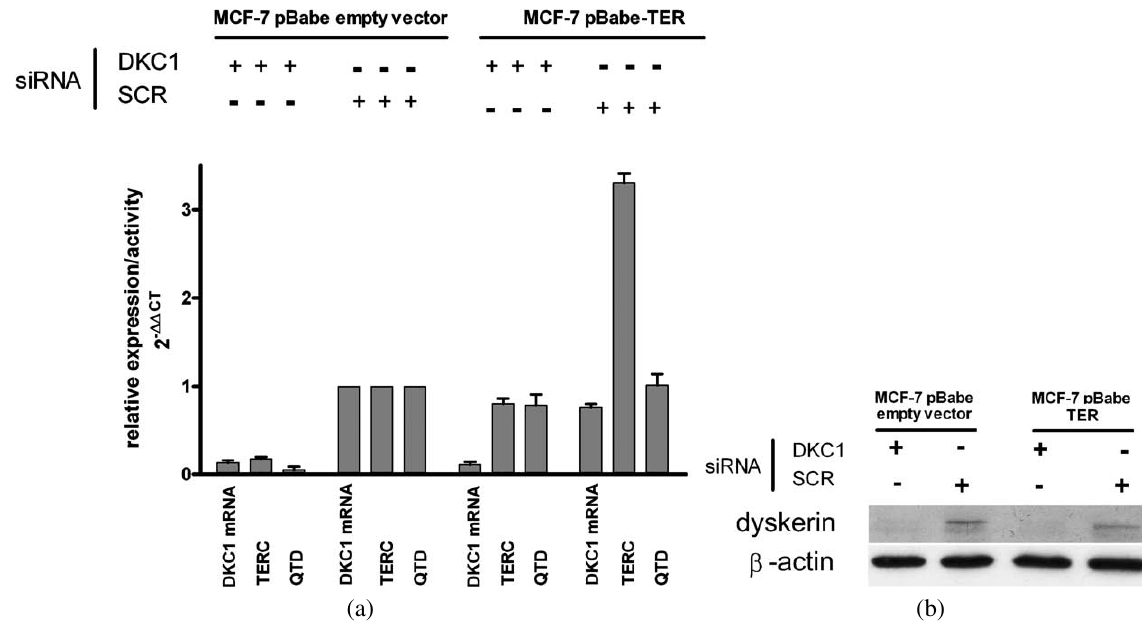
Fig. 3. The telomerase activity impairment after dyskerin reduction is mediated by TERC. MCF-7 cells overexpressing TERC (MCF-7 pBabe-TER) were generated by retroviral mediated transduction. (a) The decrease in TERC levels 96 h after DKC1 mRNA specific RNAi in MCF-7 pBabe-TER is much less intense than that observed in control MCF-7 generated by the infection with an empty pBabe-Puro vector (MCF-7 pBabe empty vector). Even in presence of a steep decrease of DKC1mRNA and dyskerin, the persistence of TERC is sufficient to com- pletely revert the observed telomerase impairment (QTD – quantitative telomerase detection: telomerase activity measured by real time PCR). All measures are expressed as arbitrary values, relative to the expression or the activity of controls (MCF-7 pBabe empty vector cells transfected with control siRNA – SCR). The experiment was repeated in triplicate. Bars: standard deviations. (b) Western blot analysis demonstrating that both in MCF-7 pBabe-TER and in MCF-7 pBabe empty vector DKC1 mRNA knock down resulted in a strong reduction of dyskerin levels after 96